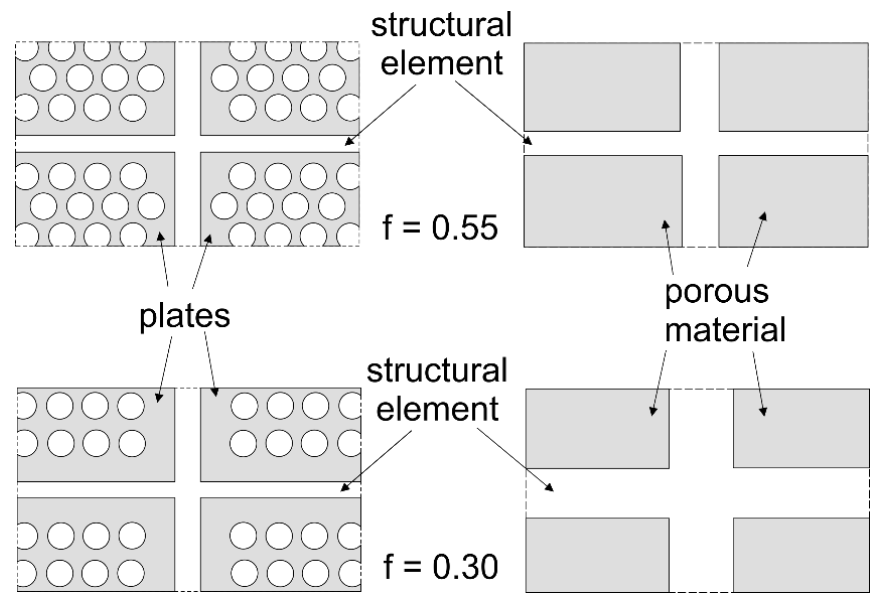
Figure 11. Perforated plate panel vs. porous plate panel for open area ratios f = 0.55 and f = 0.30.